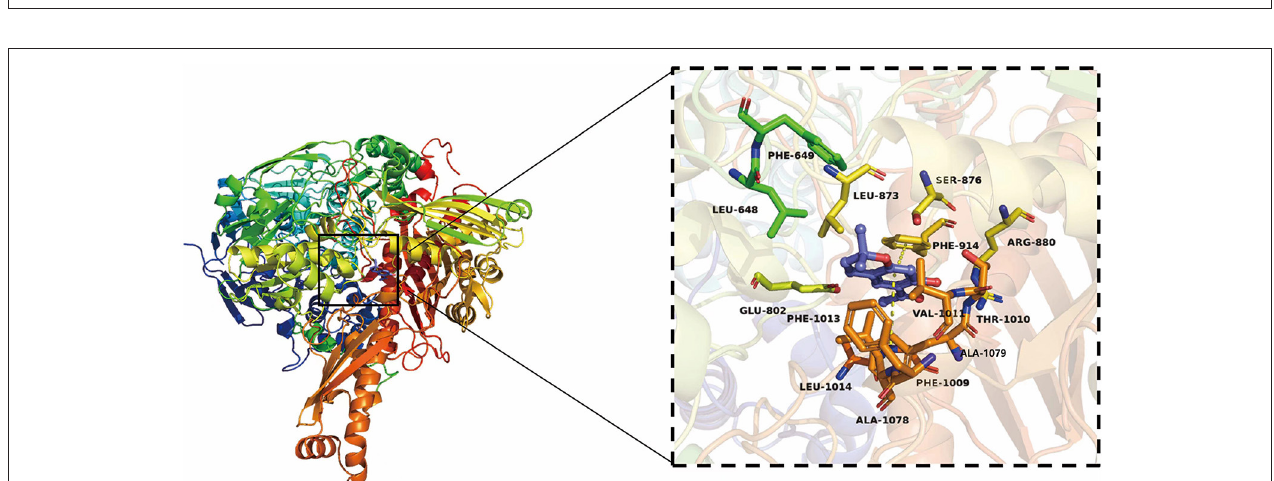
FIGURE 5 | Inhibitory activities of SEOs from different varieties of sunflowers on XO.